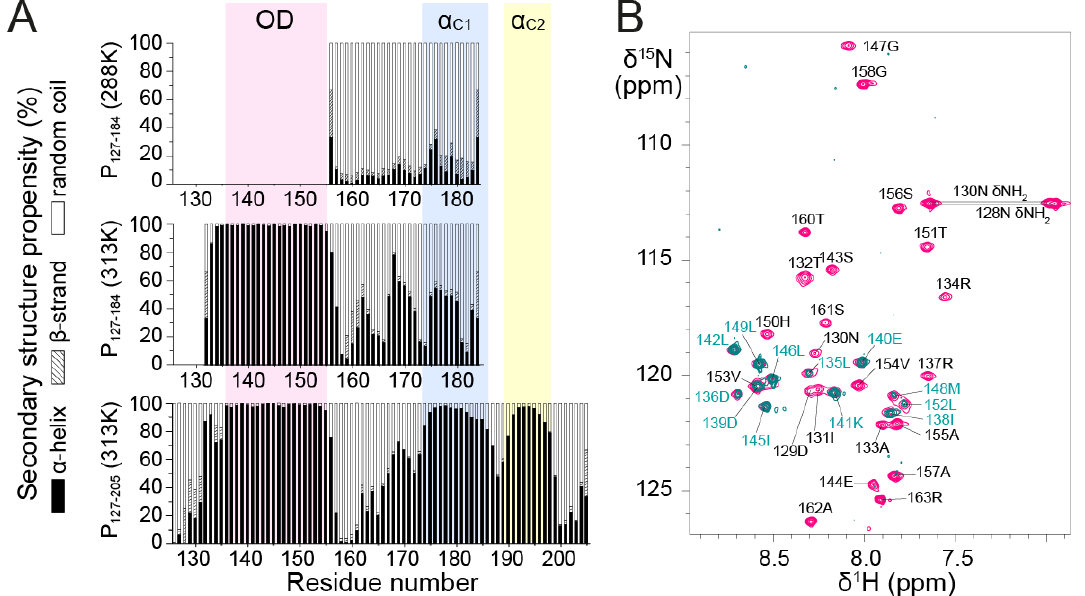
Figure 3. NMR data and secondary structure propensities of RSV phosphoprotein fragments containing P OD and C-terminal extensions of variable lengths. ( A ) Secondary structure propensities for α-helix, β-strand and random coil were determined from backbone chemical shift by using the TalosN server [47] . 13 Cα, 13 CO, 13 Cβ and 1 Hα values were used as an input for P 127–184 and P 127–205 at 313 K. Only 13 Cα values were available for P 127–184 at 288 K. ( B ) Amide 1 H/ 2 H exchange experiment by NMR. 2D 1 H- 15 N HSQC spectra of 15 N-labeled P 127–163 before (pink) and after exchange into 100% 2 H 2 O buffer (teal) were overlaid. Measurements were carried out at a temperature of 298 K on an 800 MHz NMR spectrometer. Assignments for amides that are protected from water exchange are indicated in cyan.